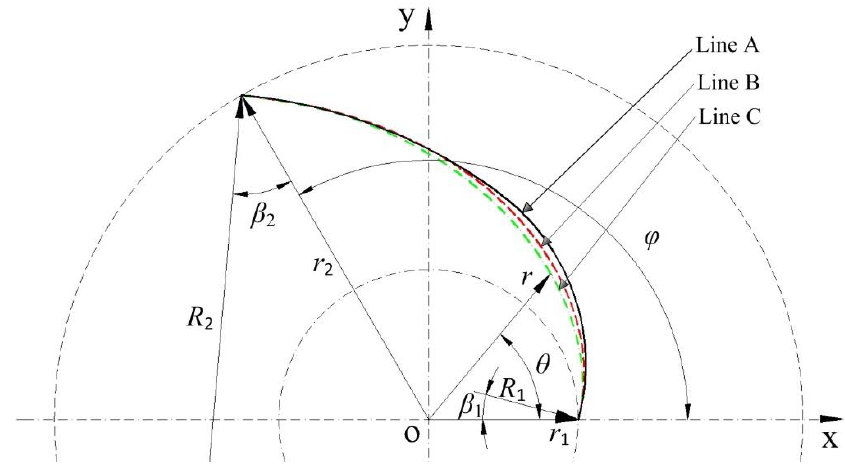
Figure 2. Three different kinds of curvature lines [28].